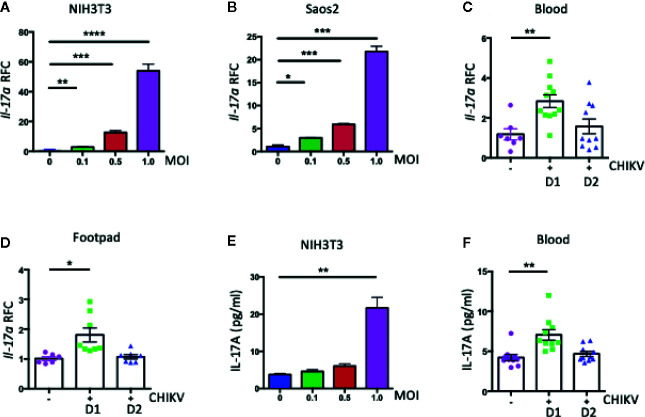
CHIKV infection induces the expression of Il17a in mouse and human. (A, B) The expression of Il17a transcripts was measured by QPCR in NIH3T3 (A) and Saos2 (B) cells that were infected with indicated MOIs of CHIKV for 24 h and expressed as Relative Fold Changes (RFC) after normalization to cellular β-actin transcripts. WT (C57BL/6J) mice (7 to 8 weeks old) were inoculated with CHIKV (1 × 105 PFU) or vehicle control (PBS) via footpad, and blood was collected on days (D) 1 and 2 post-infection (p.i.). (C, D) RFC in the expression of Il17a transcripts in blood (C) and footpad (D) of CHIKV-infected mice was compared with that of mock-infected control mice after normalization to β-actin. (E, F) The protein levels of IL-17A was measured by ELISA in NIH3T3 cells (E) and mice blood (F). The results were analyzed either by using one-way ANOVA followed by Tukey’s test (A, B, E) or a two-tailed student’s t-test (C, D, F). The results are representative of at least two independent experiments and are expressed as mean ± the standard errors of the mean (SEM) [n = 3 biological replicates for (A, B, E); n = 7 to 11 mice/group for (C, D, F). *, **, ***, and **** denote p < 0.05, p < 0.01, p < 0.001, and p < 0.0001, respectively.